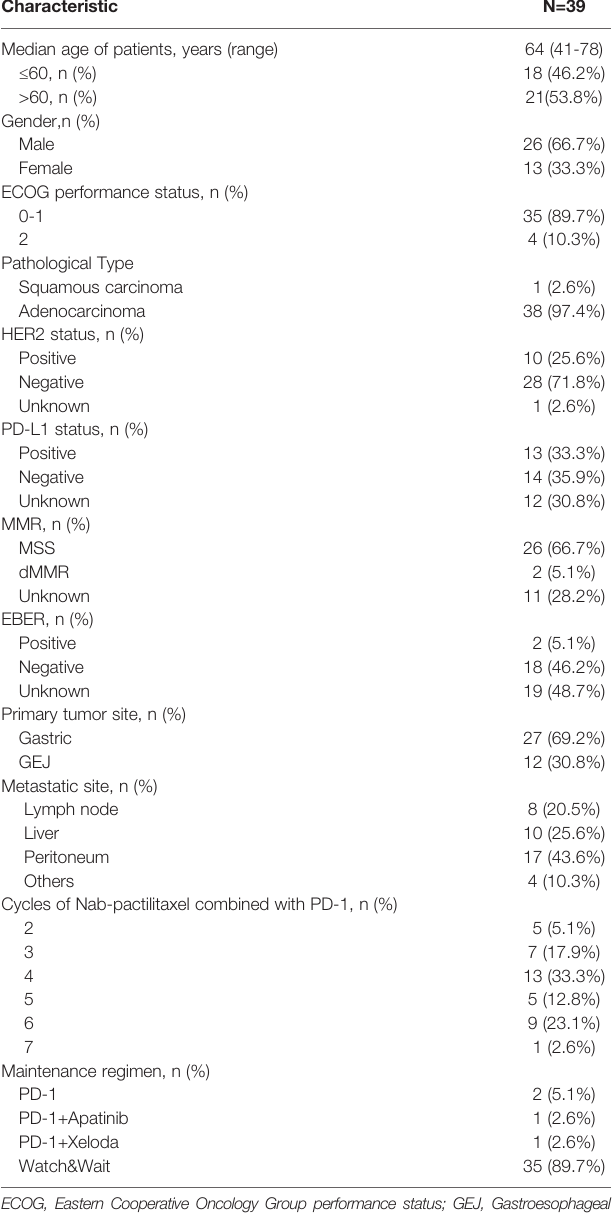
TABLE 1 | Demographic and clinicopathologic characteristics of patients. Characteristic N=39